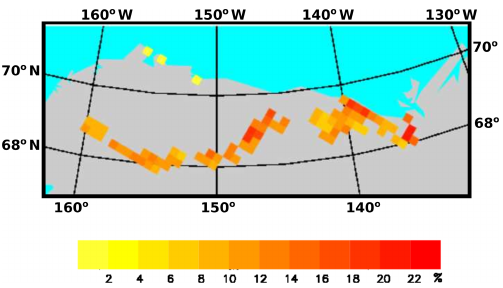
Figure 8. Change in F sub (%) over the period 1981–2010. Mapped grids show a significant change at p < 0 . 05 based on a two-sided test.